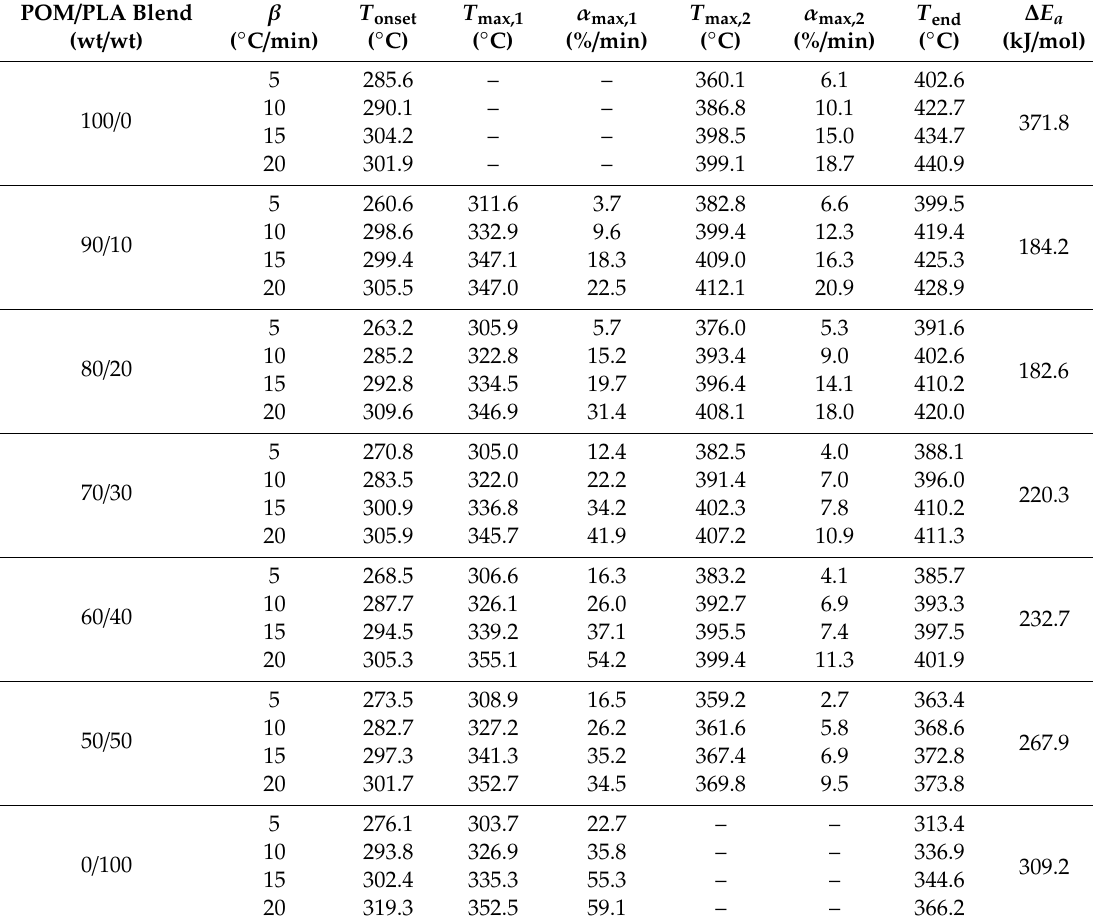
Table 2. The thermal degradation kinetic date obtained from thermogravimetric (TGA) measurements for pure POM, PLA, and their